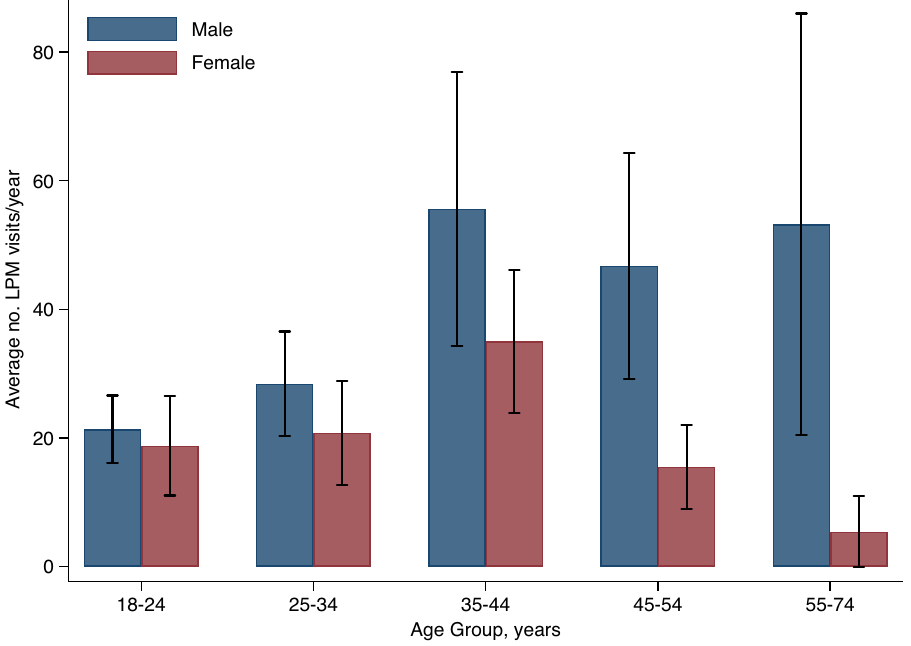
Figure 1. Live poultry markets visits reported in the past year, by sex and age group, Dhaka City Corporation, Bangladesh. Annual live poultry market visiting varied by age and sex. The average number of visits was consistently higher amongst males than females across all age groups, and the greatest number of visits were recorded amongst individuals aged 35–44 years in both